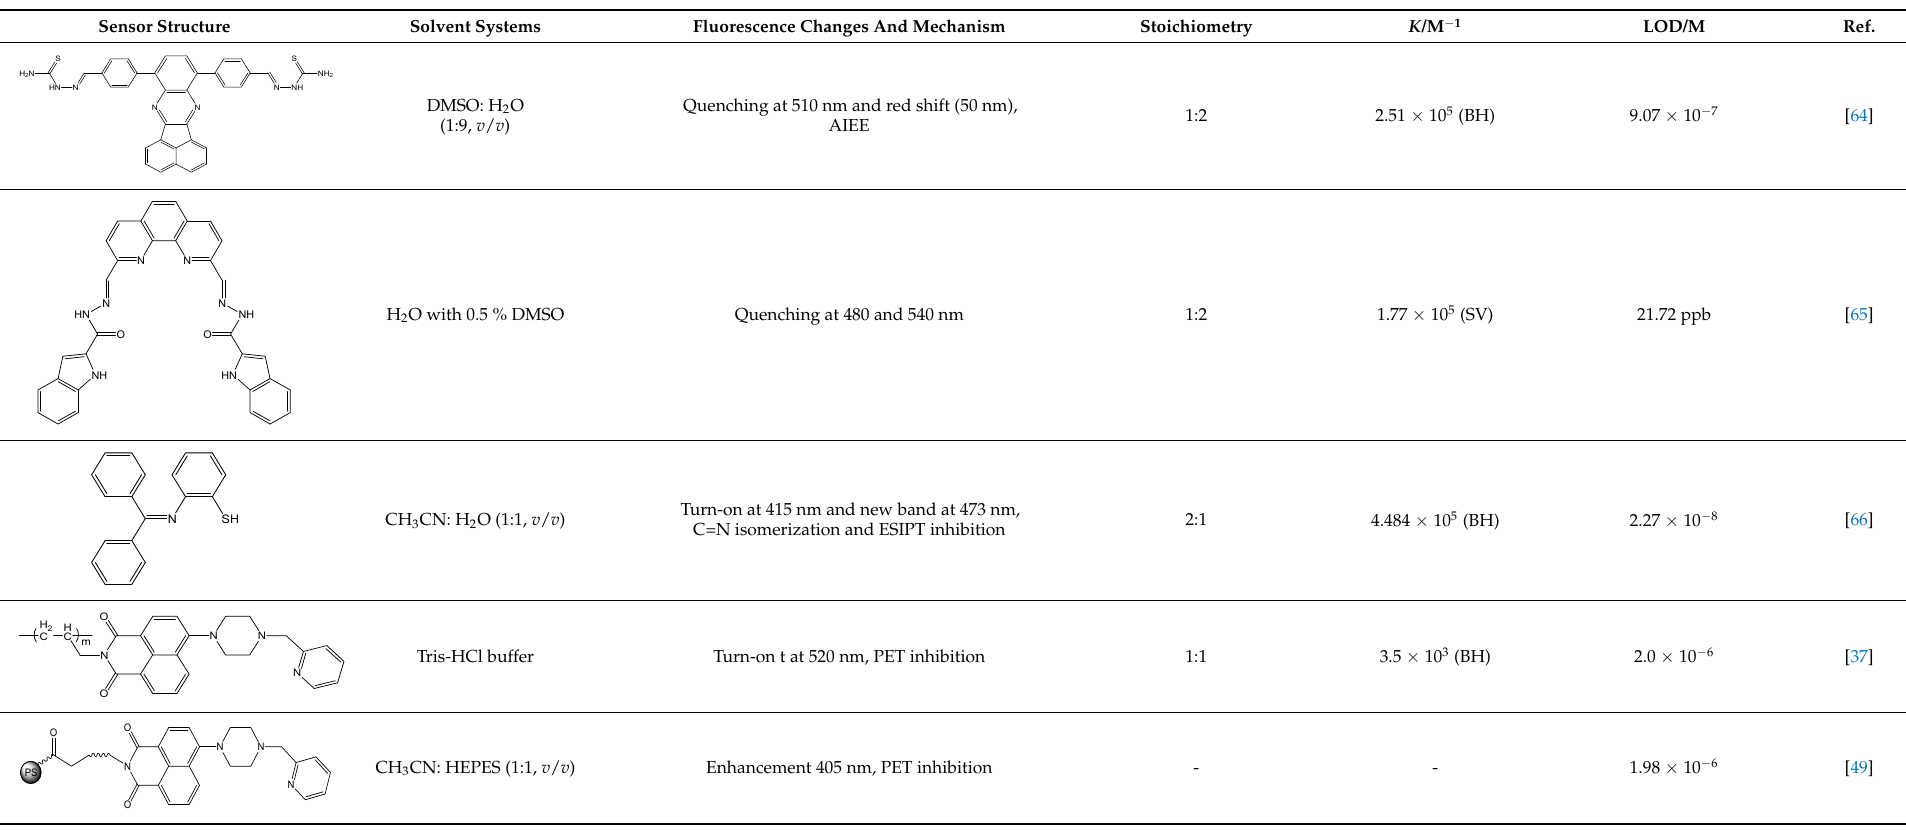
Table 3. Solvent systems, fluorescence changes, mechanism, stoichiometry (Ligand: Analyte), K and LOD values of sensors on complexation with Hg 2+ ions.